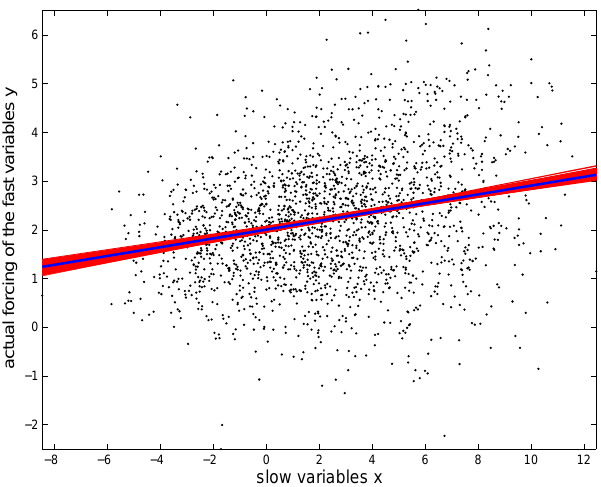
Fig. 6. Actual forcing of fast variables (black cloud). Red lines indicate forcing from MCMC runs. Red lines in the figure represent results from the 50 day MCMC simulations. Blue line is gotten by formally fitting the parameter values in the